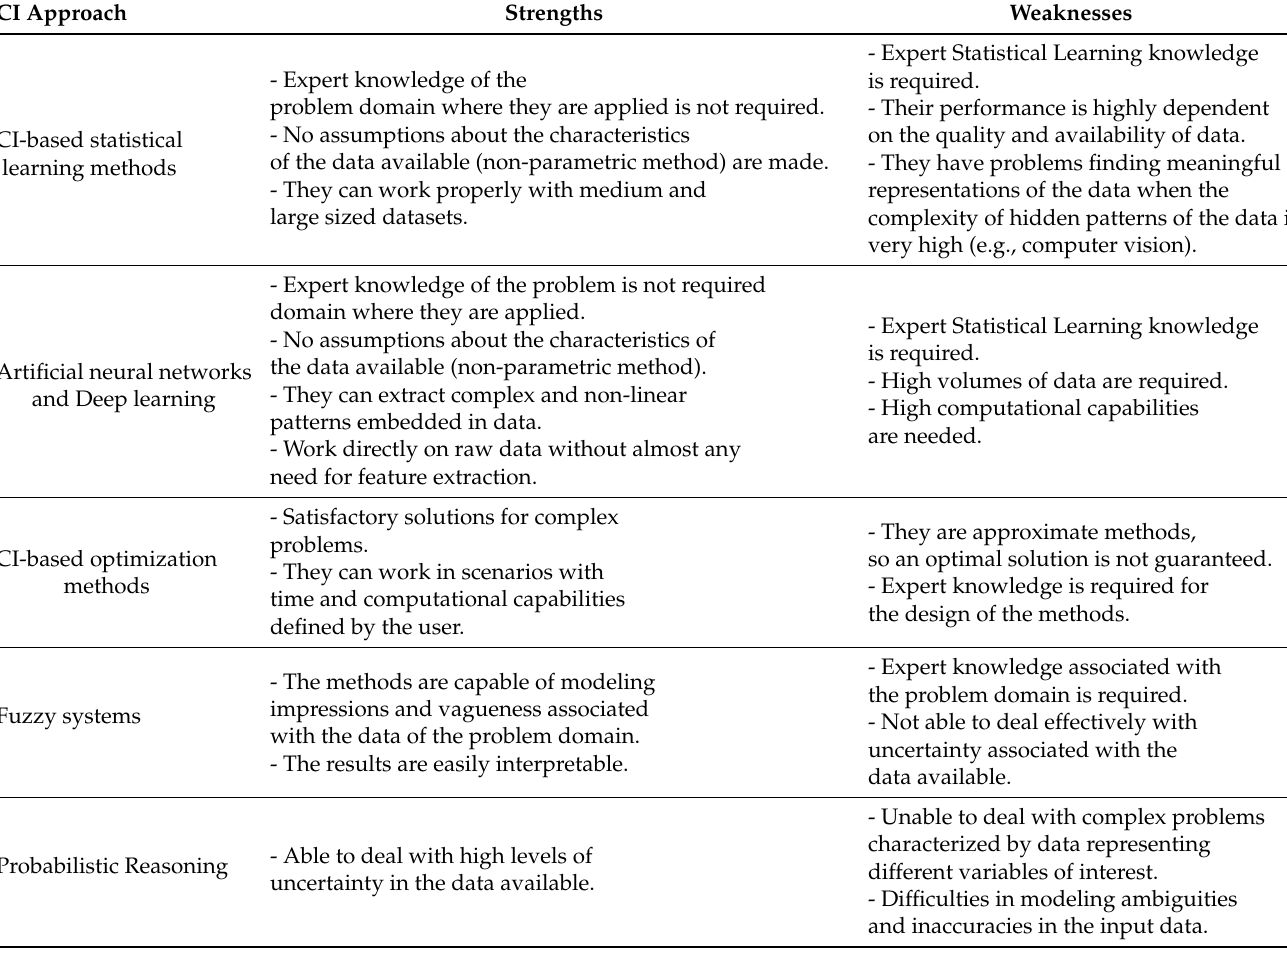
Table 1. Summary of CI-based approaches